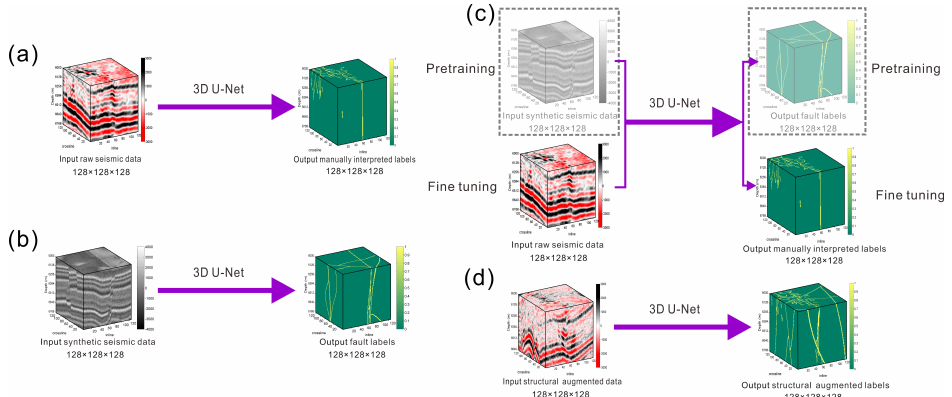
Figure 9. Network training based on ( a ) manual interpretation data, ( b ) synthetic data, ( c ) transfer learning, and ( d ) structural data